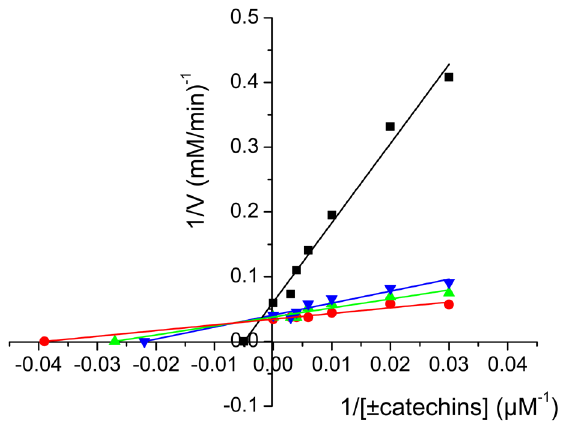
Figure 3. Experiment similar to the Lineweaver- Burk method for the evaluation of K tyrosinase assays. The substrate was a mixture of catechin and epi catechin, and concentrations of L-DOPA for each plot were 0 ( ■ ), 167 ( ▼ ), 233 ( ▲ ) and 333 ( ● )